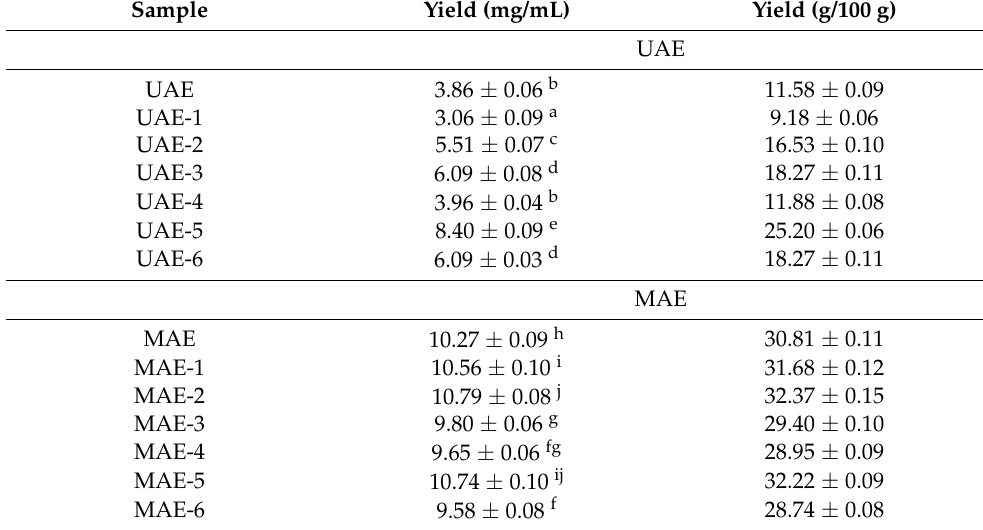
Table 2. Extraction yield of the obtained